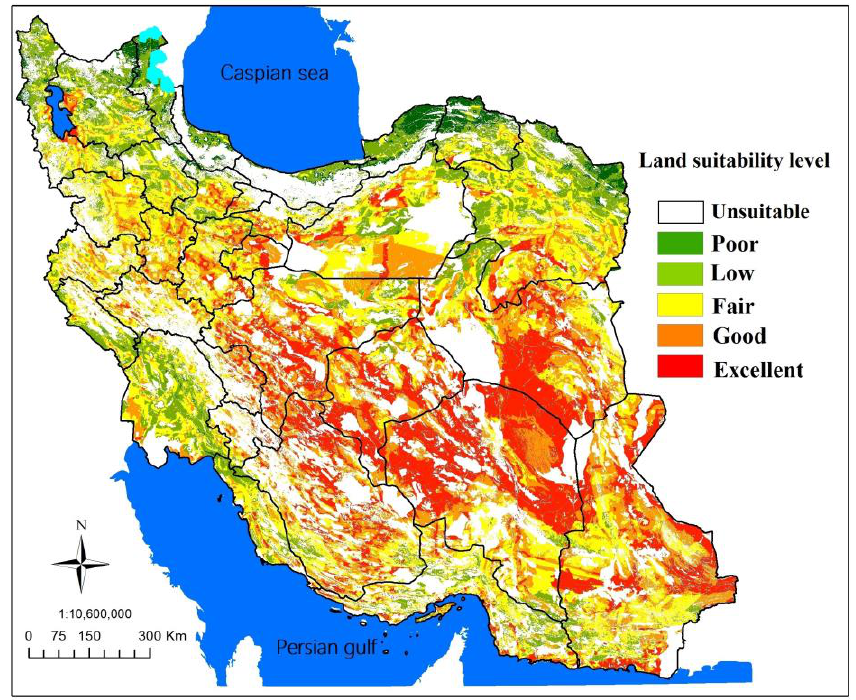
Figure 6. Classified land suitability map for exploiting solar PV farms.